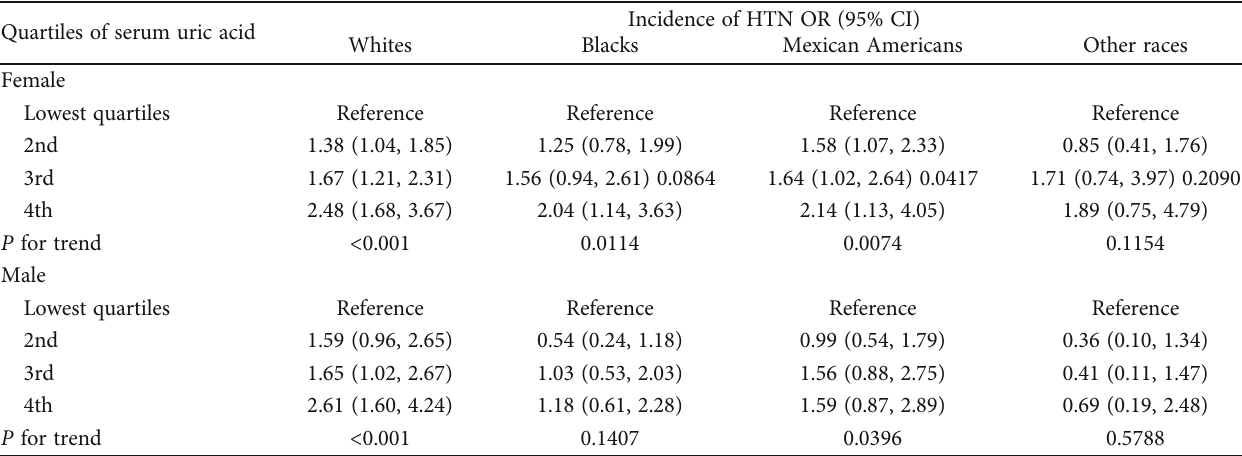
Table 3: Subgroup analysis strati fi ed by race and sex.